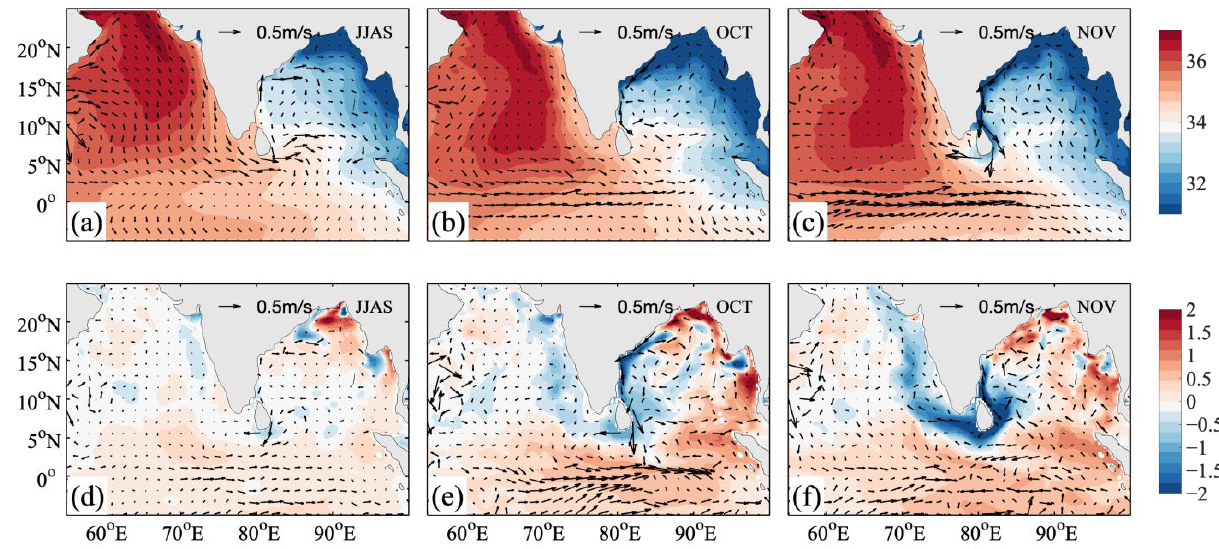
Figure 8. Mixed layer salinity and current climatology ( a – c ) and anomaly ( d – f ) in 2010 summer and autumn from ORAS5.